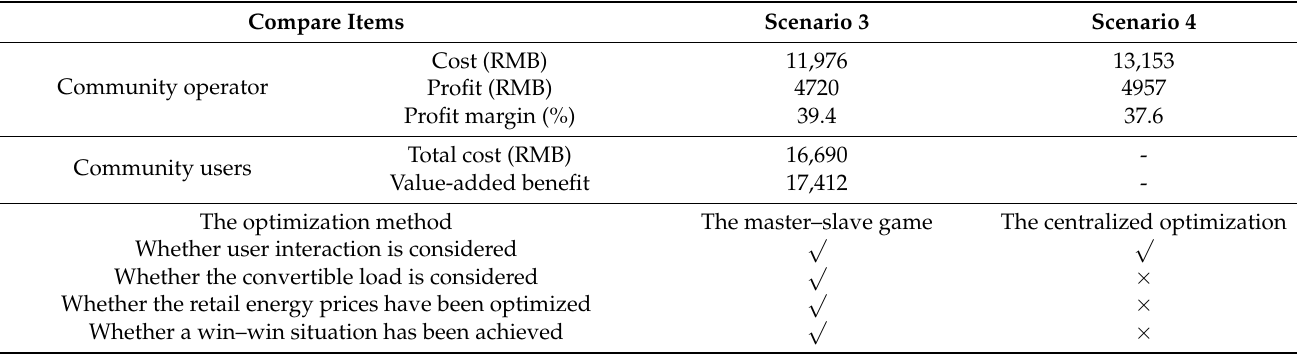
Table 2. Comparative Study